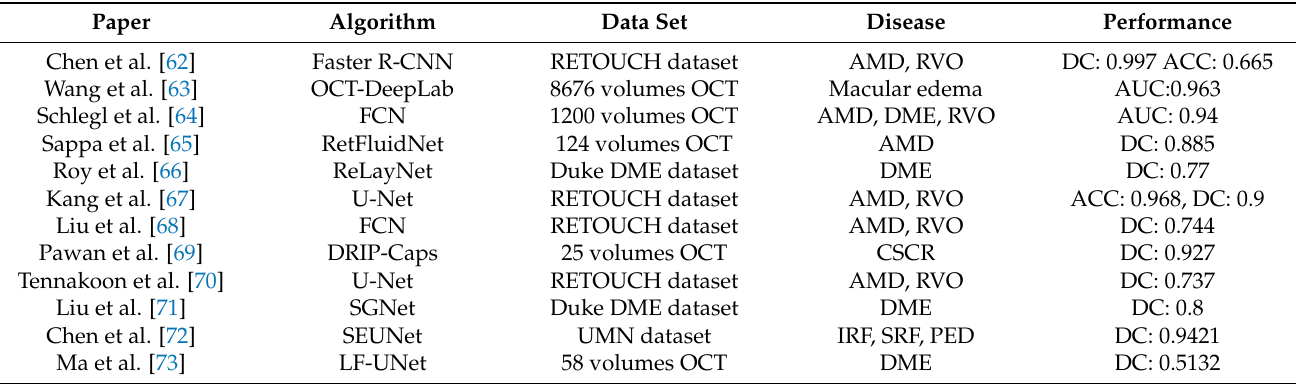
Table 3. The performance of deep learning method for cysts/fluid